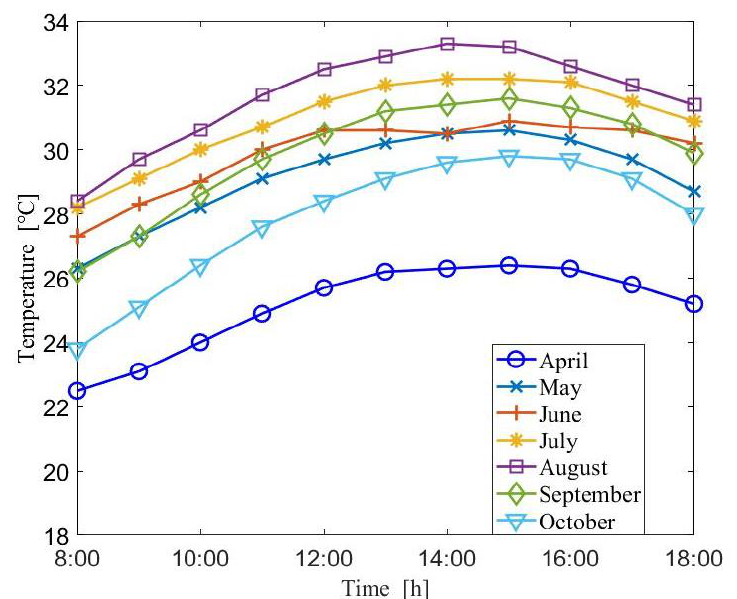
Figure 7. Ambient temperature. Appl. Sci. 2020 , 10 , x FOR PEER REVIEW